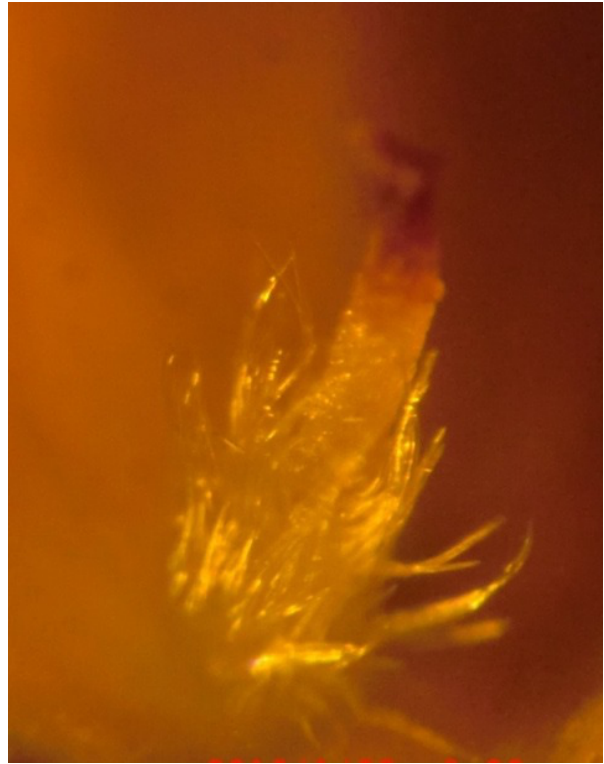
Fig. 1. Damaged pistil (0 mM SA and -4°C artificial cold